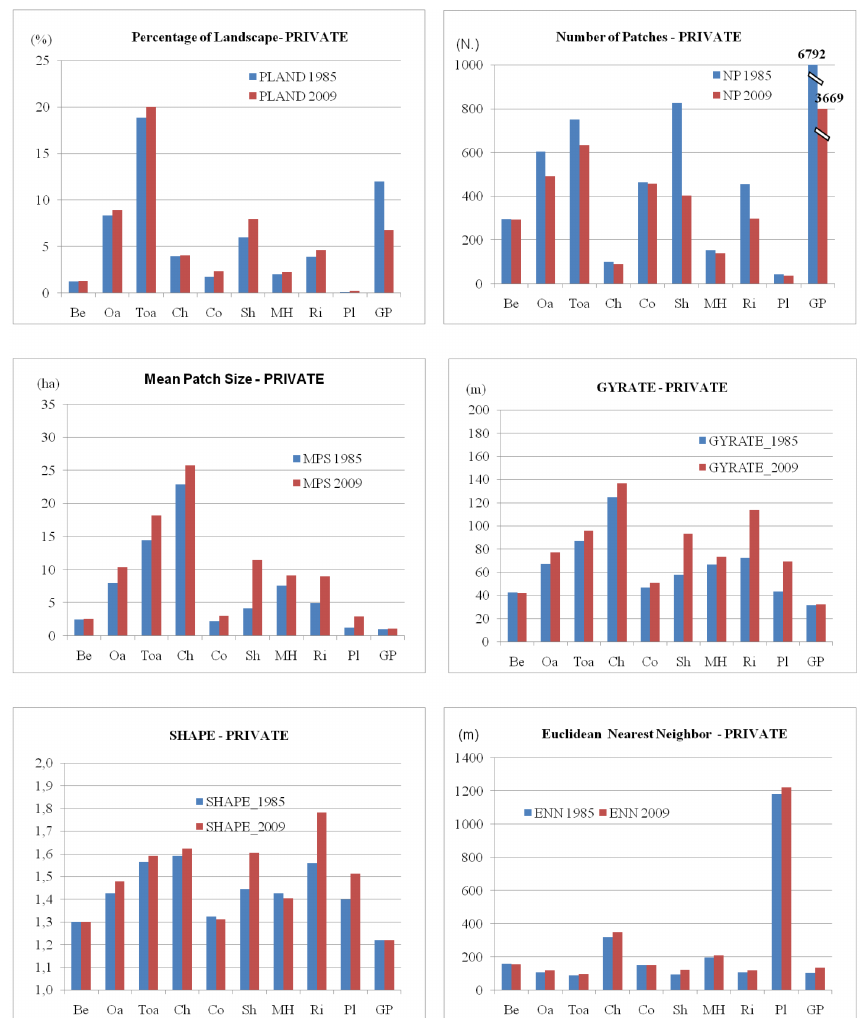
Figure 10. Histograms of the used metrics at class level for private-ownership natural covers for the complex ecomosaics (1985–2009). For further details on landscape indicators see Table